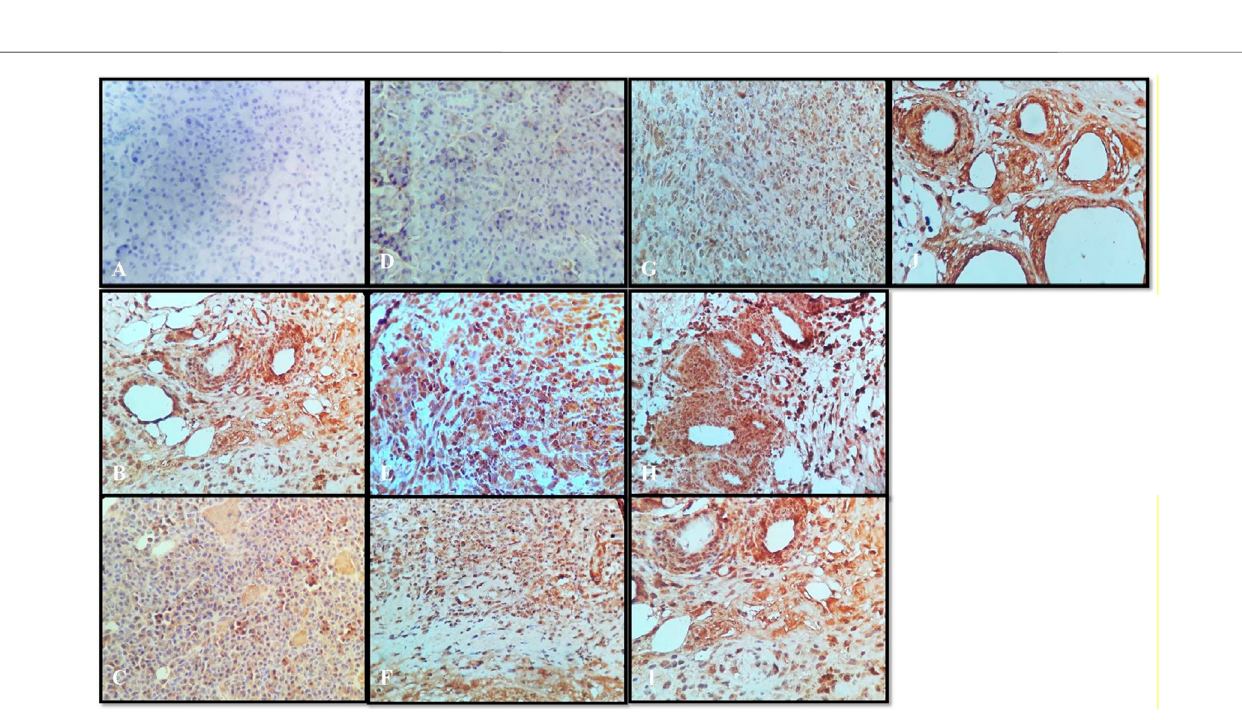
Frontiers in Pharmacology |